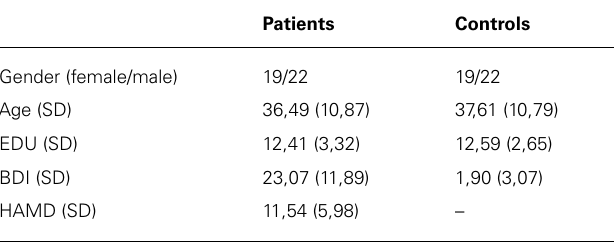
Table 1 | Demographic and clinical profile of patients and